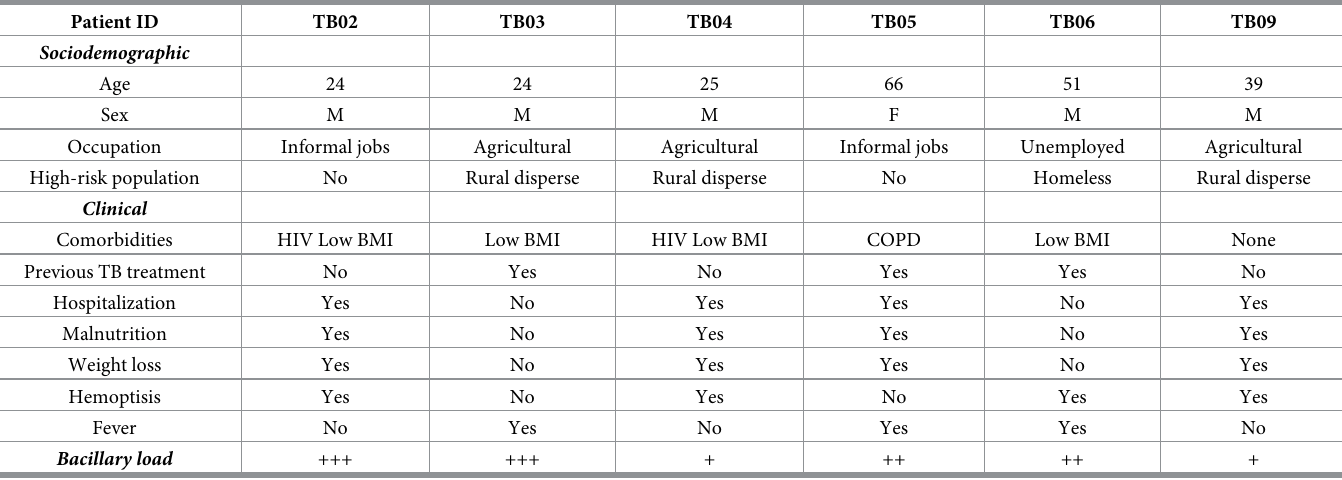
Table 1. Sociodemographic and clinical characteristics of patients with tuberculosis. Patient ID TB02 TB03 TB04 TB05 TB06 TB09 Sociodemographic Age Occupation Agricultural Agricultural Unemployed Agricultural High-risk population No Rural disperse Rural disperse Homeless